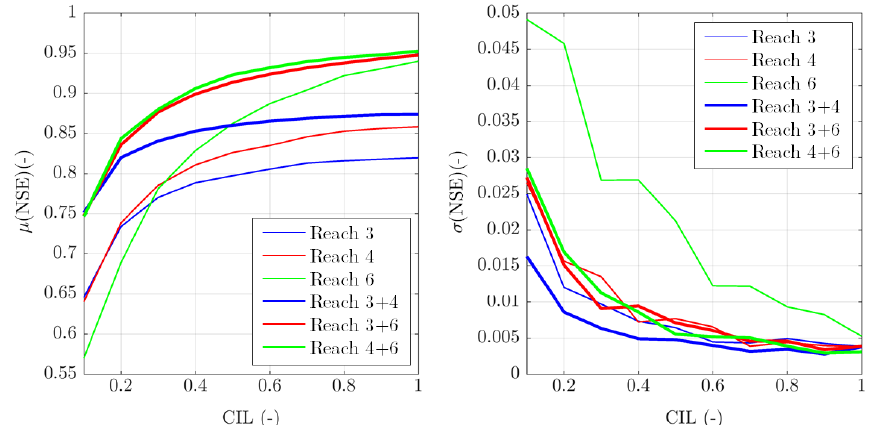
Figure 6. Effect of different levels of involvement, in terms of µ ( NSE ) and σ ( NSE ) , on the assimilation of CS observations from DySc sensors for different CIL